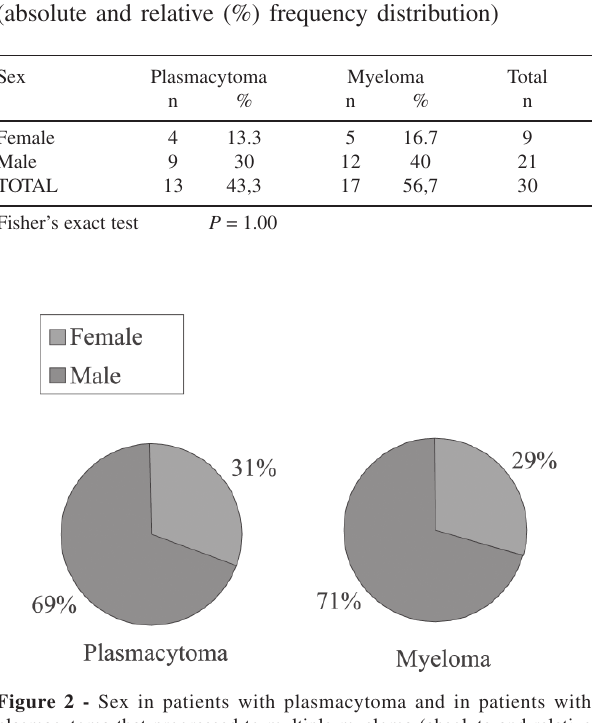
Table 2 - Sex of patients with plasmacytoma vs patients with plasmacytoma that progressed to multiple myeloma (absolute and relative (%) frequency distribution)